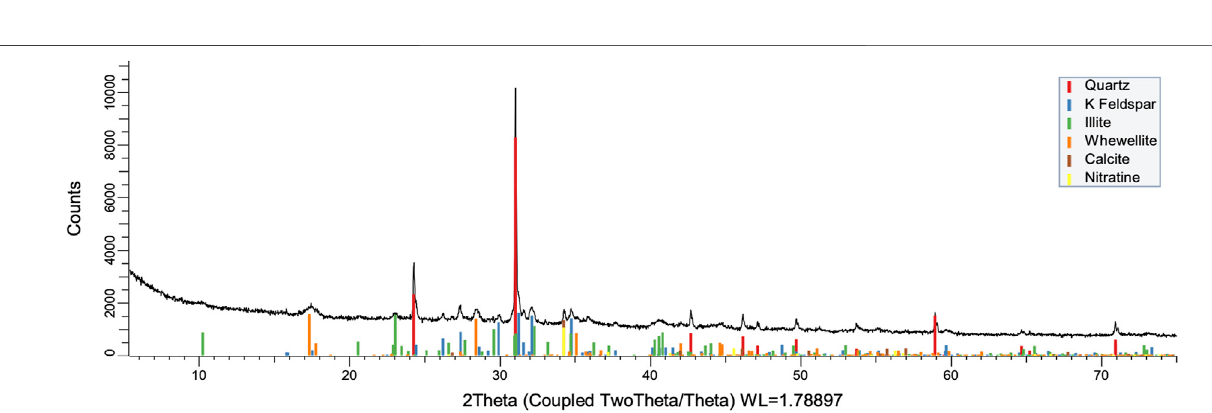
FIGURE 10 | XRD pattern of oxidation residue at 120 ° C and 1 h.